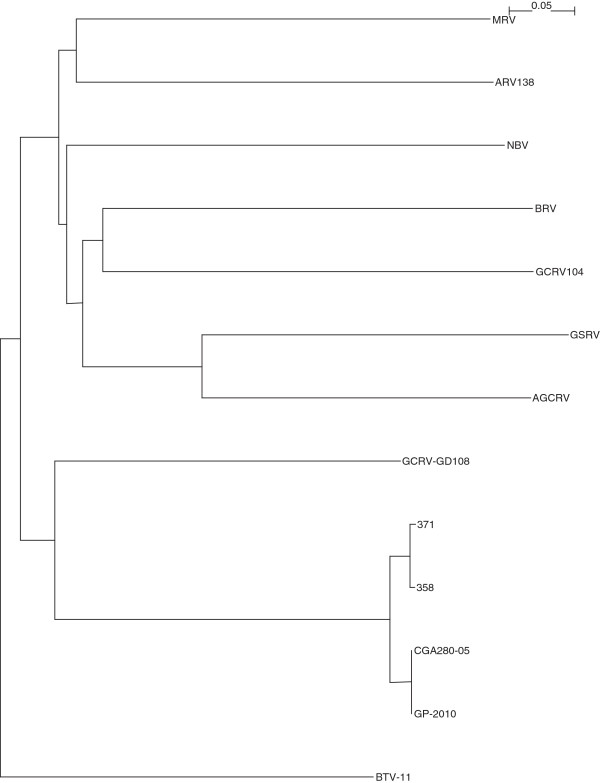
Phylogeny of homologous segment S1 shared by piscine reovirus (PRV) and selected members of familyReoviridae.